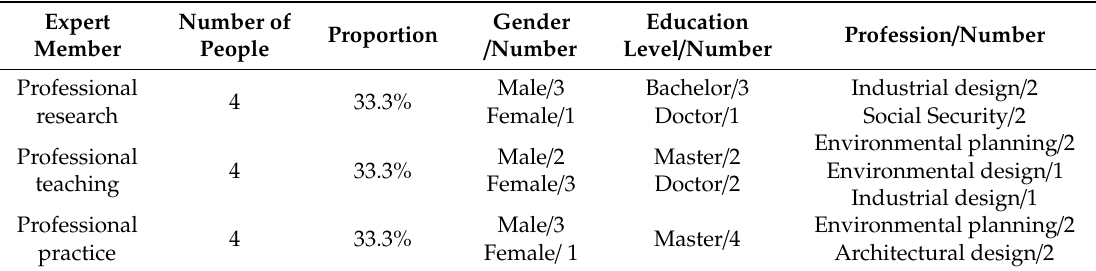
Table 7. Expert Basic